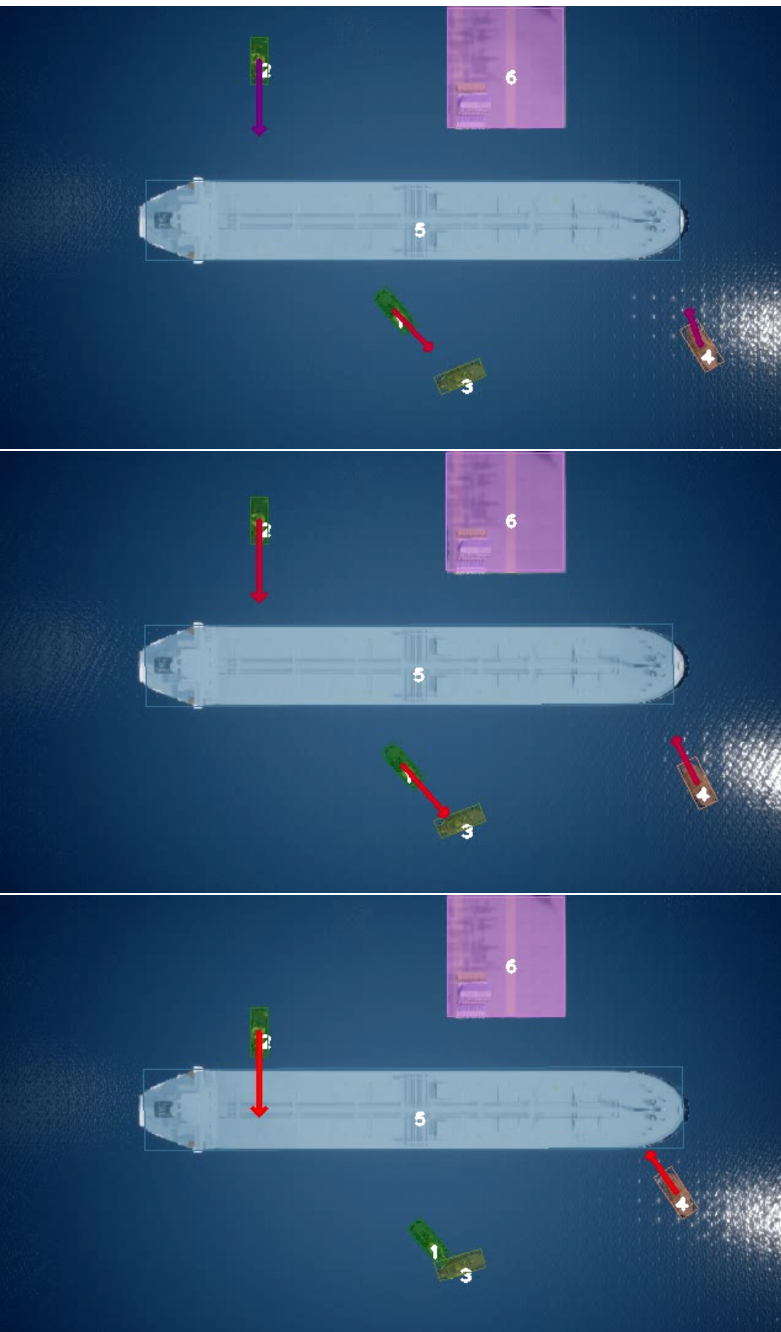
Figure 5. Sequential image samples of output of our TTC estimation approach. Each vessel is colored with a translucent color that corresponds to its segmentation